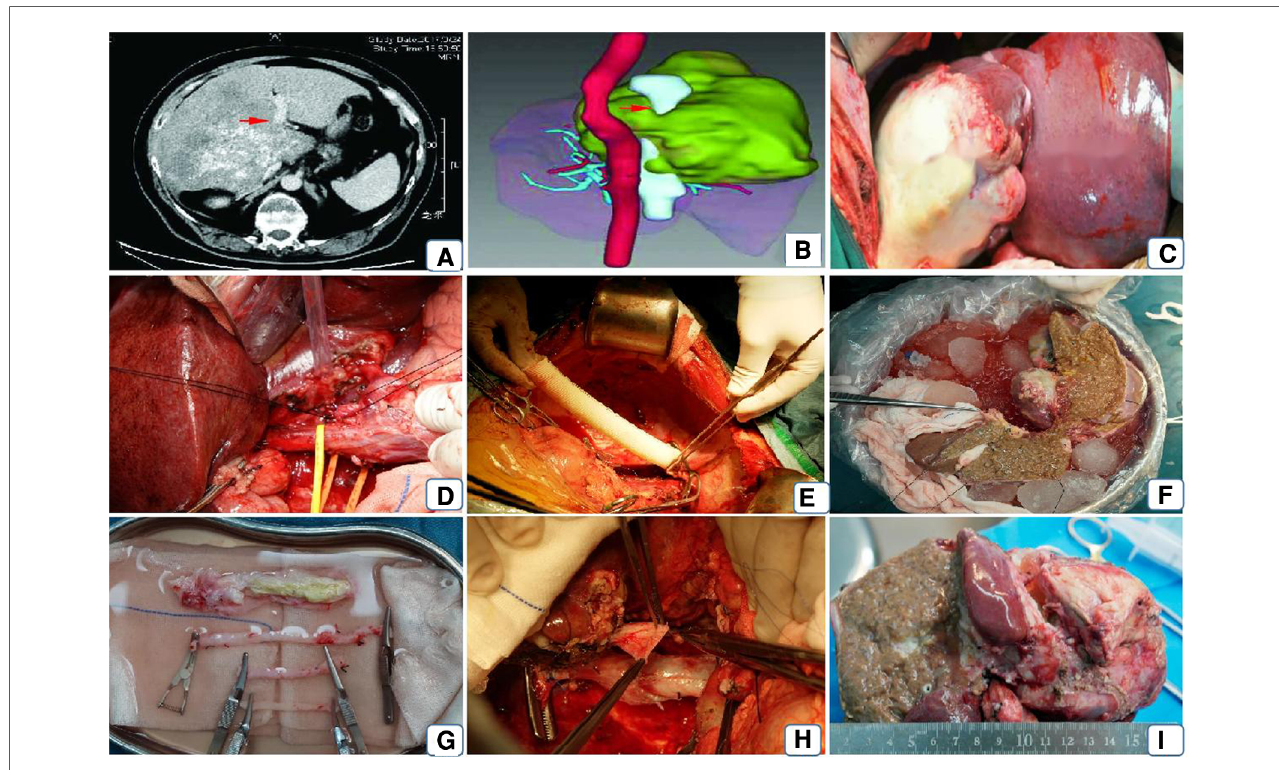
FIGURE 1 Patient ’ s preoperative imaging assessment and surgical procedure. Note: ( A ) preoperative vesicular encapsulated lesion approximately 17*17 cm in diameter, invading the right branch of the portal vein (red arrow); ( B ) preoperative 3D reconstruction showing the lesion invading the encapsulated inferior vena cava and the left and middle hepatic veins; ( C ) opening the abdominal cavity to expose the normal liver and the lesion tissue; ( D ) dissecting the fi rst hepatic portal, blocking the portal vein, the innominate hepatic artery and the common hepatic duct respectively and sharply dissecting them; ( E ) using arti fi cial vessels connect the suprahepatic and intrahepatic inferior vena cava and end-lateral anastomosis of the portal vein to the arti fi cial vessel; ( F ) ex vivo resection of the lesion and repair of the plastic in fl ow and out fl ow tract; ( G ) reconstruction of the in fl ow, out fl ow tract or inferior vena cava of the liver using autologous or allogeneic vessels; ( H ) replacement of the arti fi cial inferior vena cava by the isolated free and repaired autologous inferior vena cava; ( I ) resected